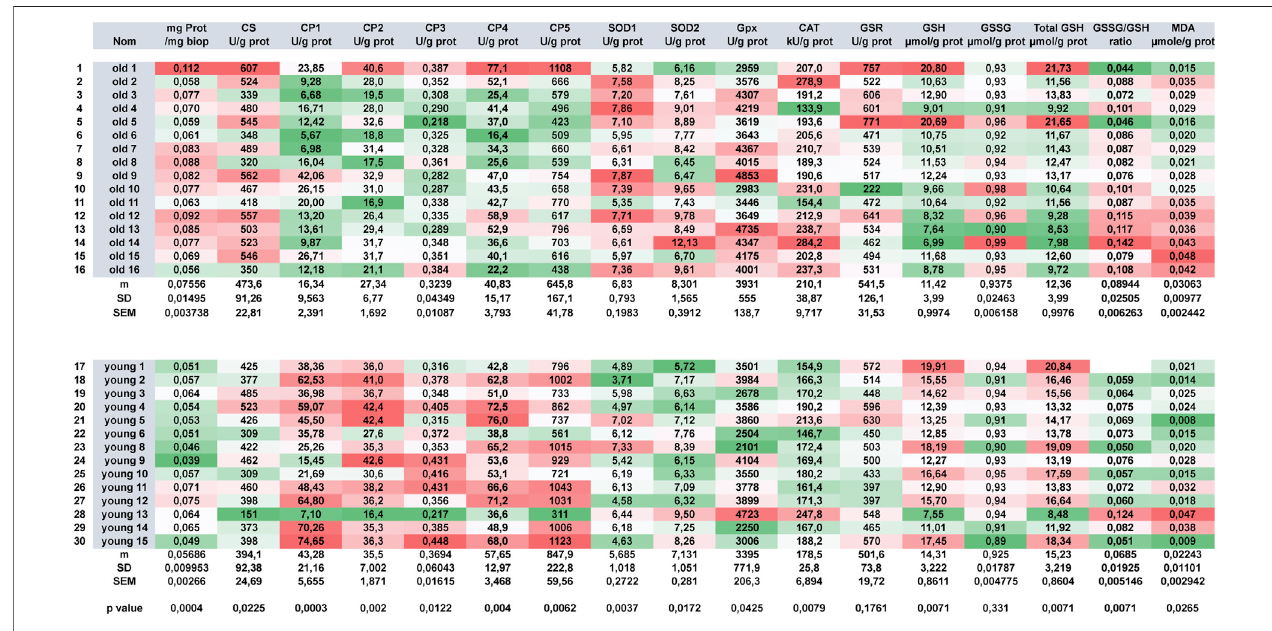
FIGURE 8 | Comparative analysis of functional metabolic activities of rat muscles. Two series of old (n (cid:1) 16) and young (n (cid:1) 14) were metabolically analyzed. A red white green 3-color diverging scale heat map (with high values getting the red color and low values getting the green ones) was used to represent the results.